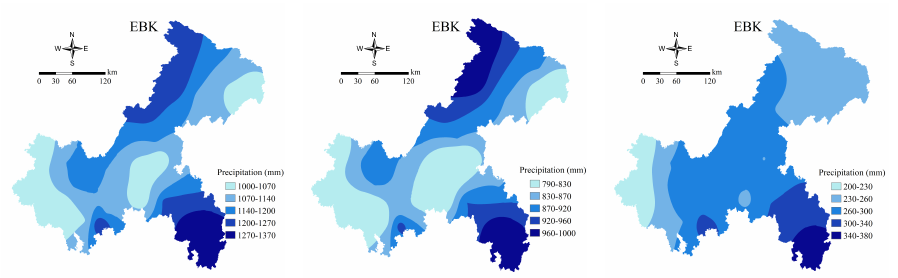
Figure 3. Precipitation spatial patterns in Chongqing under different climatic conditions based on six interpolation methods (IDW, RBF, DIB, KIB, OK, EBK): ( a ) mean annual; ( b ) rainy season; and ( c ) dry season.